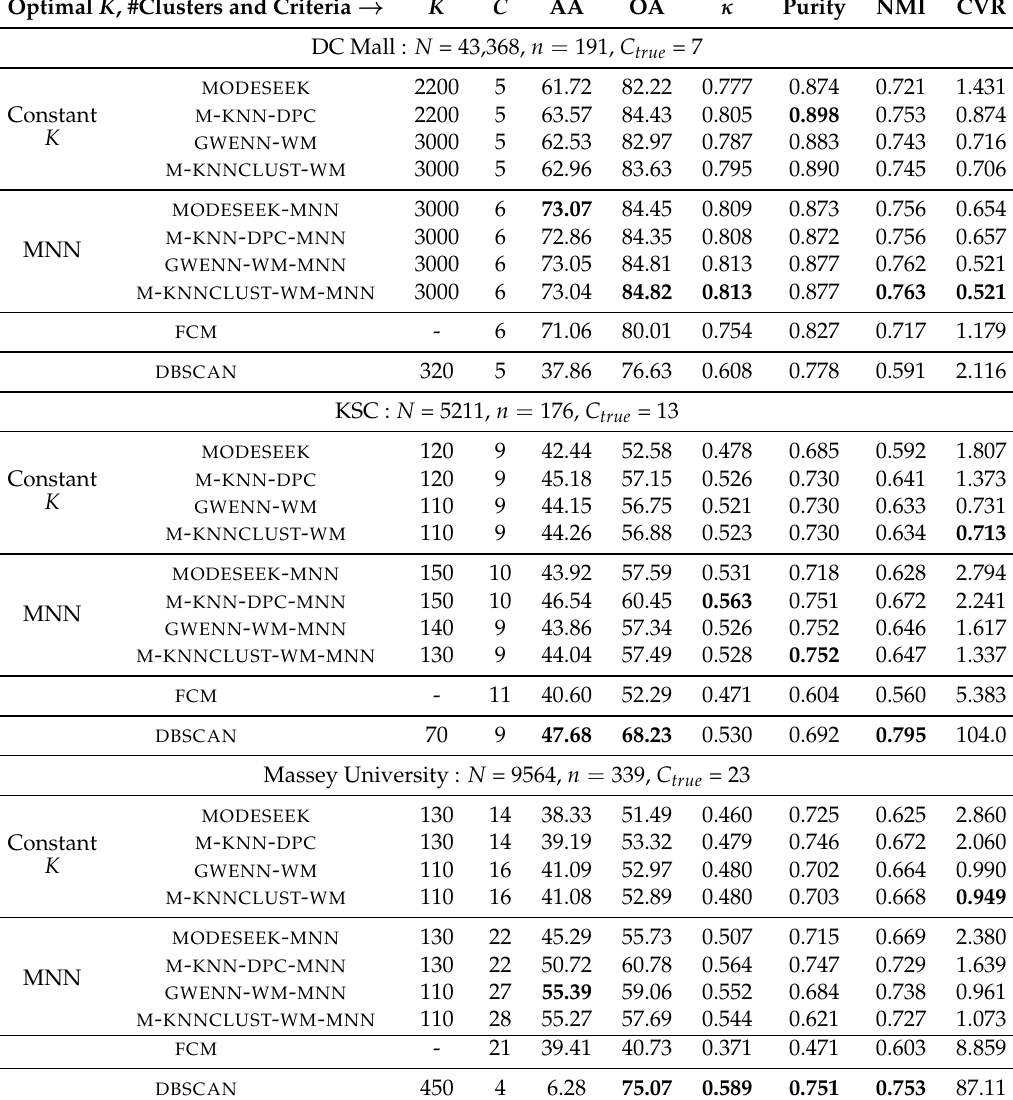
Table 3. Comparison of several clustering performance indices and numbers of clusters found for various HSIs and different clustering methods. For each method, these results correspond to the best kappa index obtained as a function of K